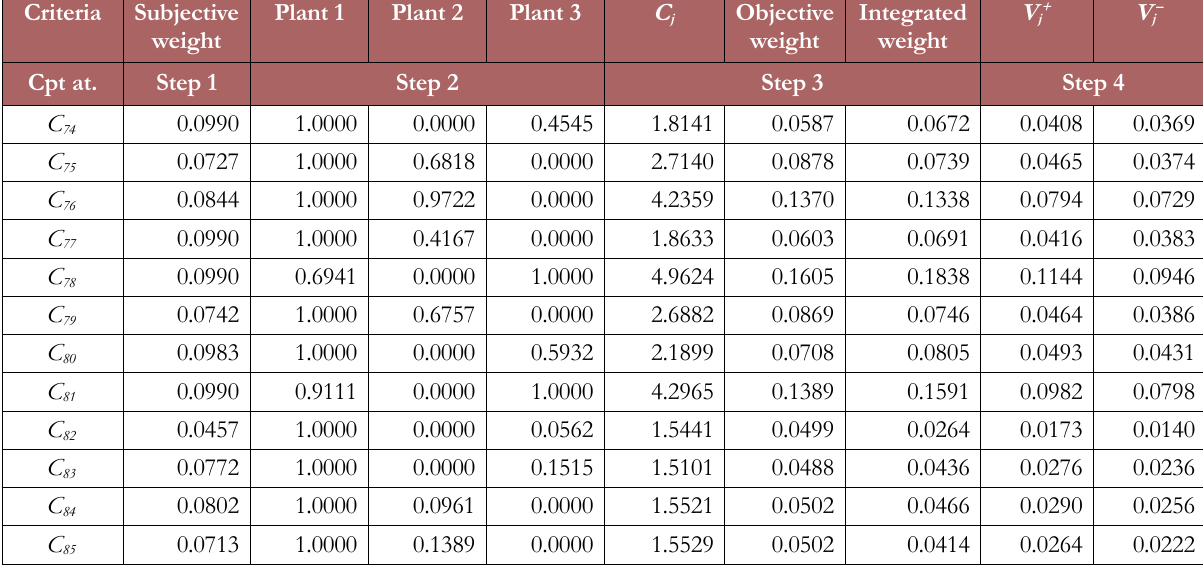
Table 17. Computation of rough BWM-CRITIC-TOPSIS (big data)